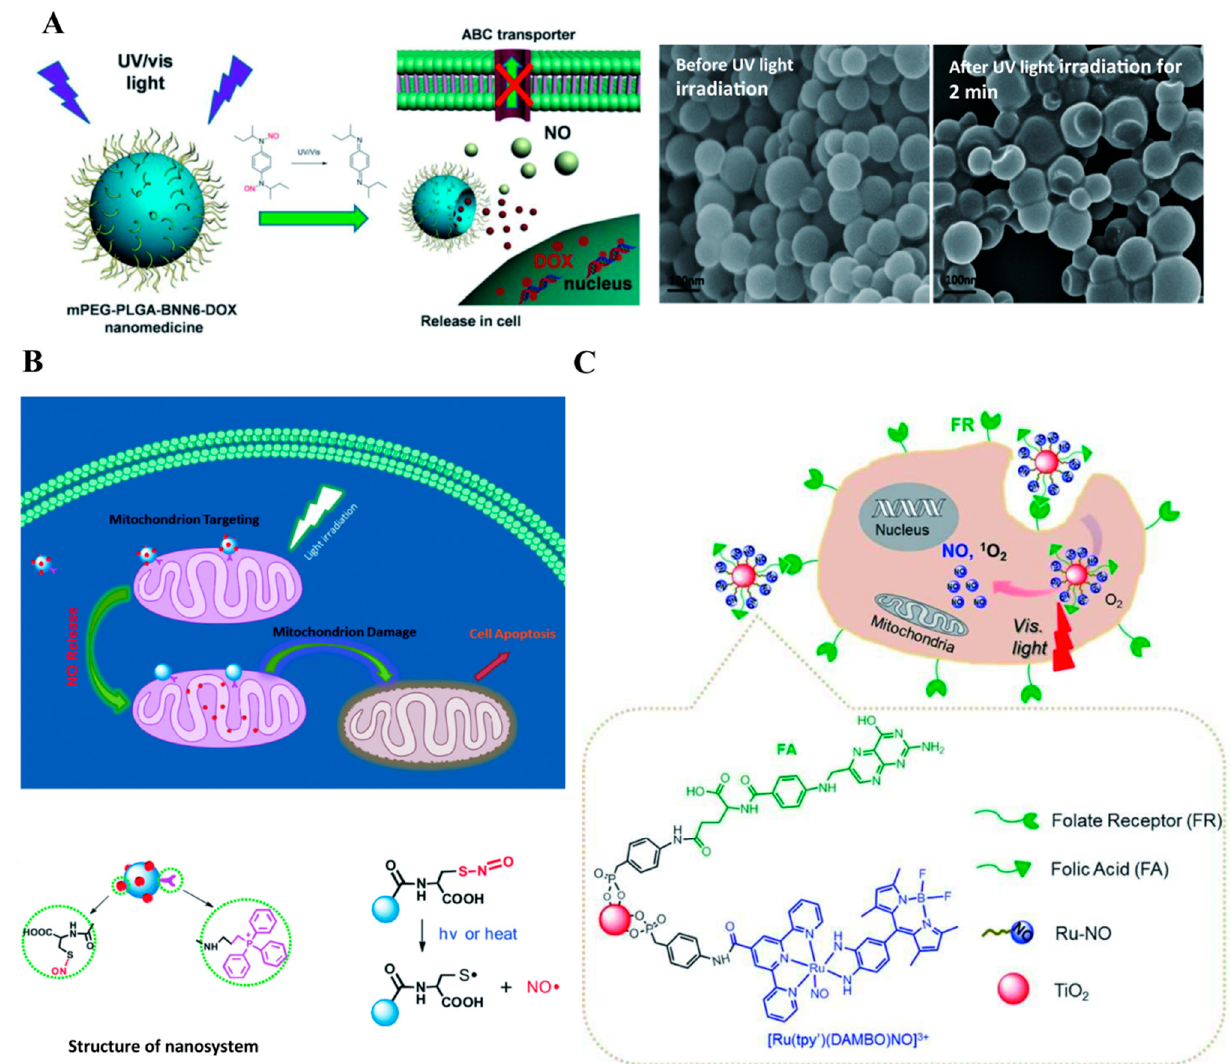
Figure 1. ( A ) Schematic diagram of NO release in cells by the mPEG–PLGA–BNN6–DOX nanosystem and the SEM images of the nanoparticles. Adapted with permission from [68], ACS Applied Materials & Interfaces, 2016; ( B ) schematic diagram of Cdot–TPP–SNO nanosystem releasing NO in cancer cells for anti-tumor therapy. Reproduced with permission from [69], Small, 2014; ( C ) schematic diagram of the NO release in tumor cells by the Ru–NO@TiO 2 NPs nanosystem. Reproduced with permission from [70], Chemical Communications, 2015.